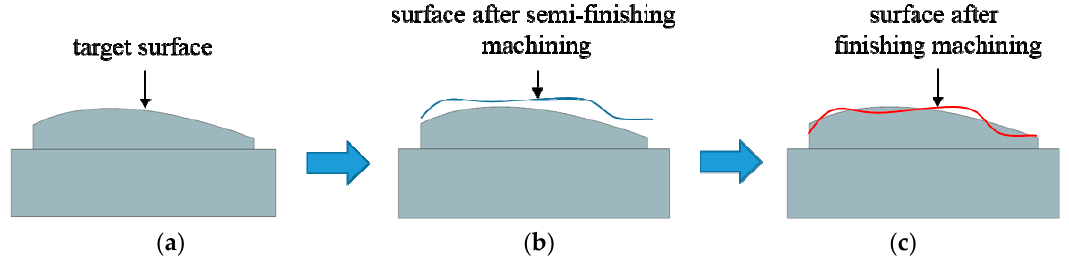
Figure 1. Illustration of the surface after semi-finishing machining and after finishing machining; ( a ) target surface of machining; ( b ) the profile after semi-finishing compared to the target surface; ( c ) the profile after finishing compared to the target surface.